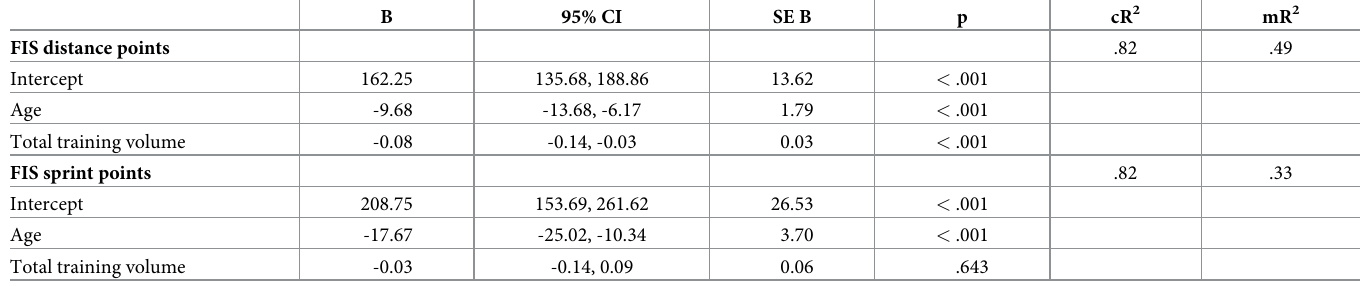
Table 3. Fixed-effects estimates (B) with 95% confidence intervals (CI), standard errors (SE) and p values for the effects of total training volume and age on perfor- mance level represented by FIS points for distance and sprint